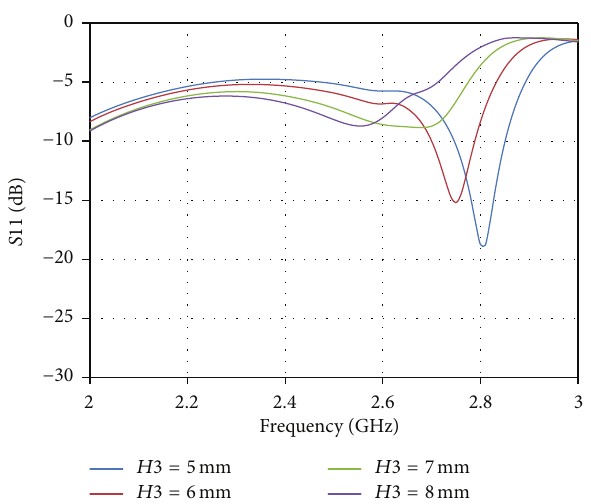
Figure 7: Parametric study on the influence of 𝐿7 .